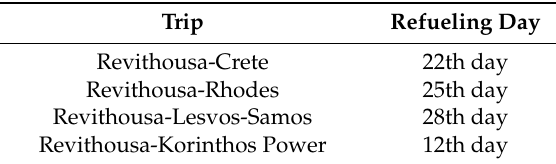
Table 6. The schedule for 3rd